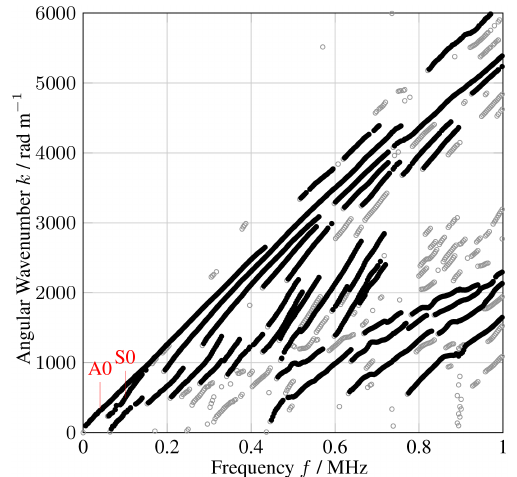
Figure 13. Correlation coefficient (cid:37) X , Y ( c l ,c t ) of the measured and simulated dispersion diagram. Maximum at c l = 2630ms − 1 and c t = 1070ms − 1